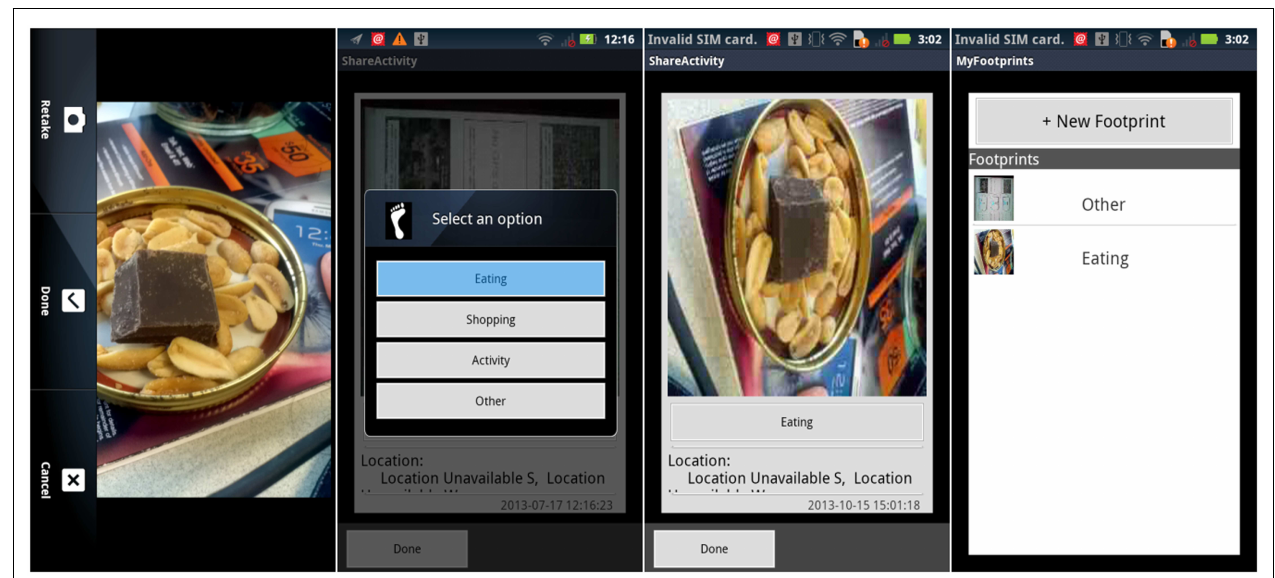
FIGURE 5 | Examples of My Footprints screen captures . Far left panel: capturing an image with the mobile phone camera; center-left panel: tagging the picture as “eating;” center-right panel: review of image and tag; far right panel: overview of recorded